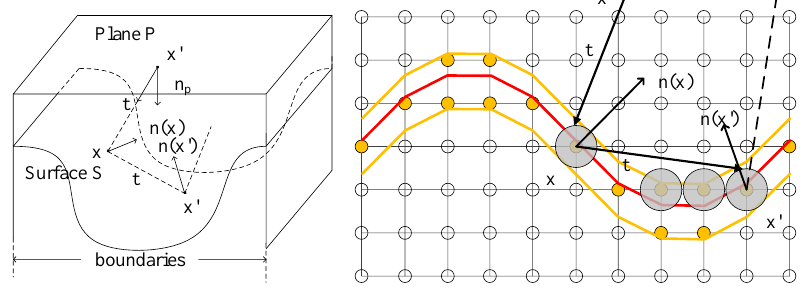
Figure 6. Illustrations of particle trajectory intersecting with group of active spheres.